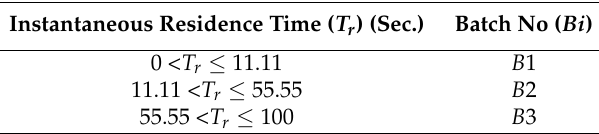
Table 5. Batch selection.